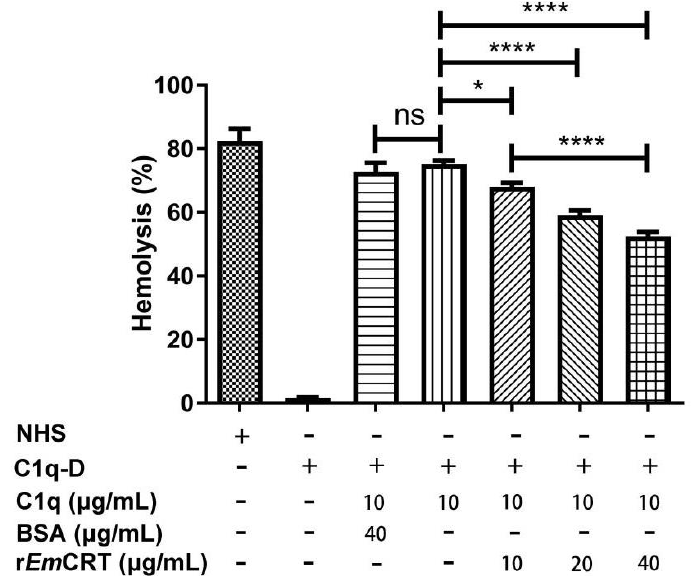
Figure 4. Complement-mediated hemolysis was inhibited by r Em CRT. C1q-mediated antibody-sensitized sheep blood cells hemolysis was inhibited by r Em CRT in a dose-dependent manner. Three independent experiments were conducted and the results were presented as means ± SDs. * p < 0.05 and **** p < 0.0001. ns, no significant difference.